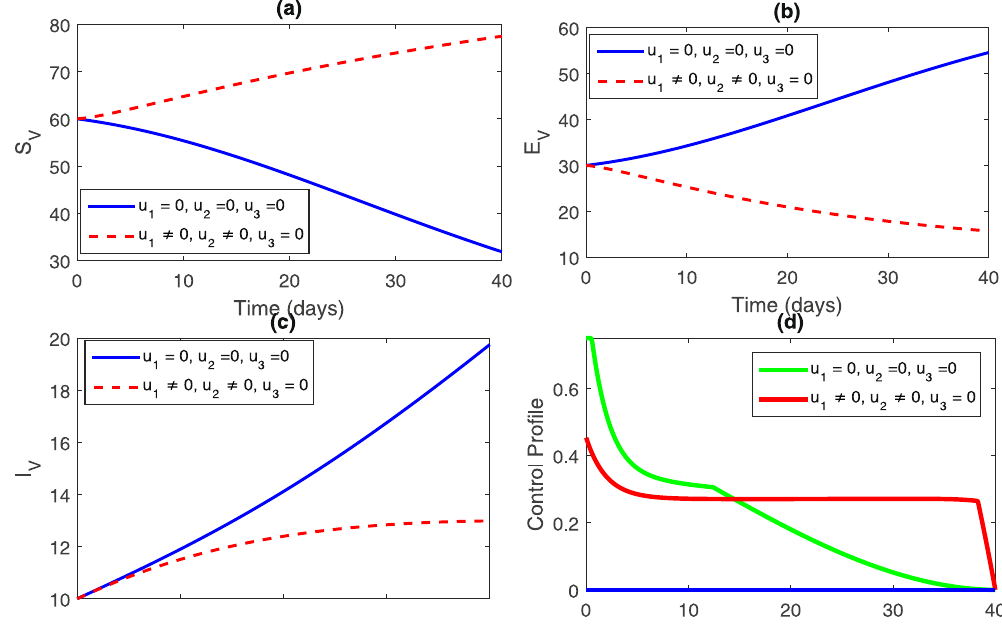
Figure 7. Comparison of both the systems: without and with control.